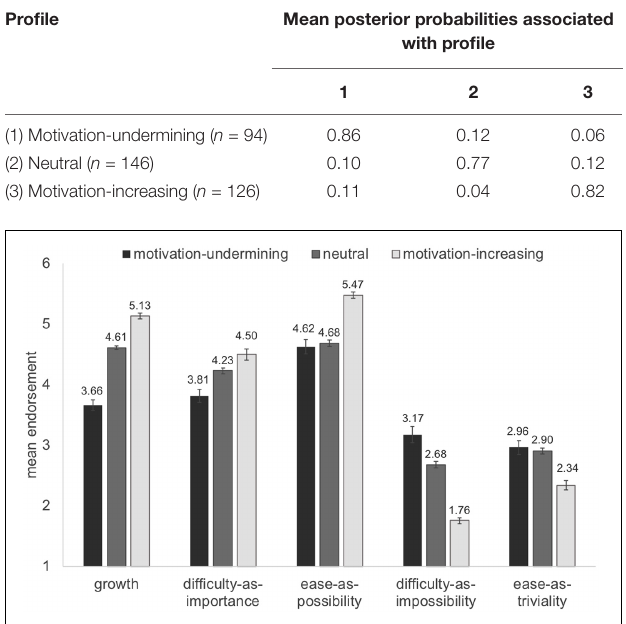
TABLE 2 | Classification table for the three-profile solution with VV/FC parameter specification.